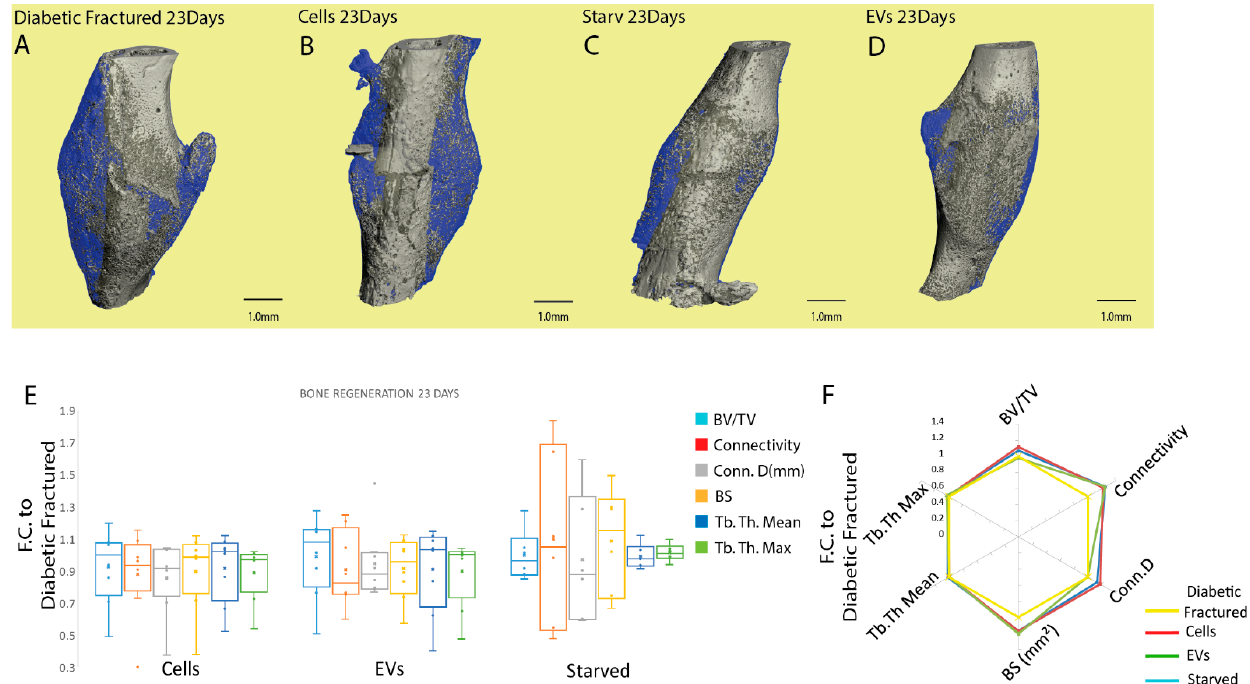
Figure 7. Analysis of the newly formed mineralized tissue at 21 days after cell and EV injection at the fracture site. ( A – D ) Three-dimensional femur reconstruction showing cortical and trabecular newly formed mineralized matrix (grey) and the presence of a lightly mineralized soft callus (blue) at the 23 day post-fracture time-point. ( E , F ) Treatment with regularly fed, starved cells and EVs had no effect on bone regeneration at the later time-point (23 days) as evident by μ CT parameters BV/TV ratio, connectivity, Conn.D (mm − 3 ), BS (mm 2 ), trabecular Tb. Th. Mean (mm), Tb. Th. Max (mm). Data are normalized to diabetic animals that had a femoral fracture but only received a PBS injec- tion. The results are presented as mean fold change ± SD (sample size five to eight animals/group, one-way ANOVA followed by Fisher’s post hoc test). Scale bars: 1 mm. Abbreviations: micro-com- puted tomography ( μ CT); regularly fed cells (cells); starved cells (starved); extracellular vesicles (EVs); fold change (F.C.); bone volume/total volume (BV/TV); connectivity density (Conn.D (mm − 3 )); bone surface (BS(mm 2 )); trabecular thickness mean (Tb. Th. Mean (mm)); ( p ≤ 0.05); trabecular thick- ness max (Tb. Th. Max (mm)); trabecular spacing mean (Tb. Sp. Mean (mm)); trabecular spacing max (Tb. Sp. Max (mm)). 4. Discussion